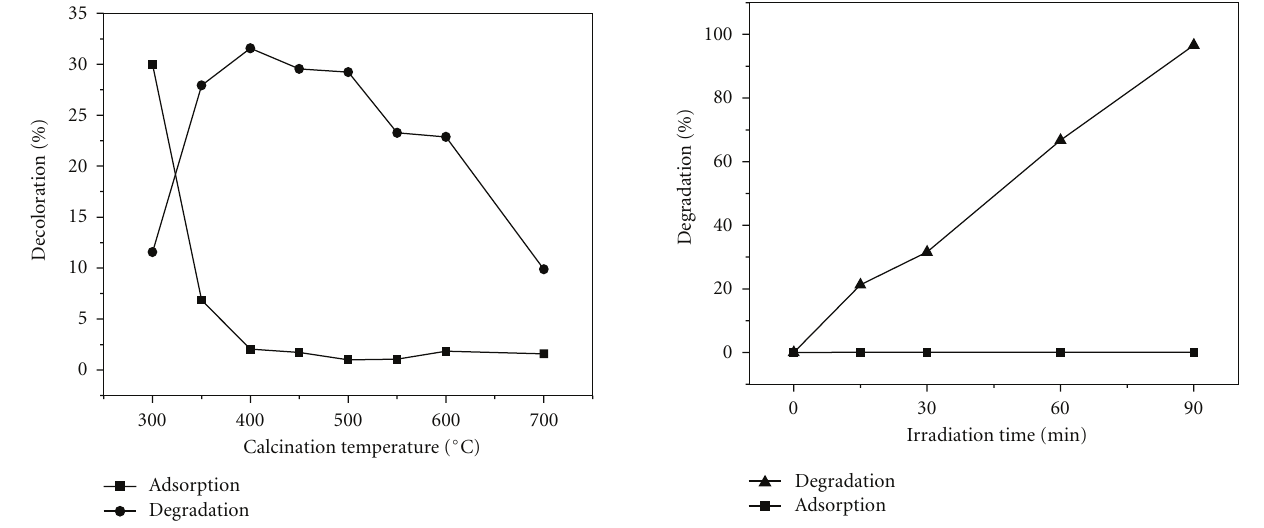
Figure 6: Photocatalytic activities of 3% B-TiO 2 samples calcinated at di ff erent temperatures.